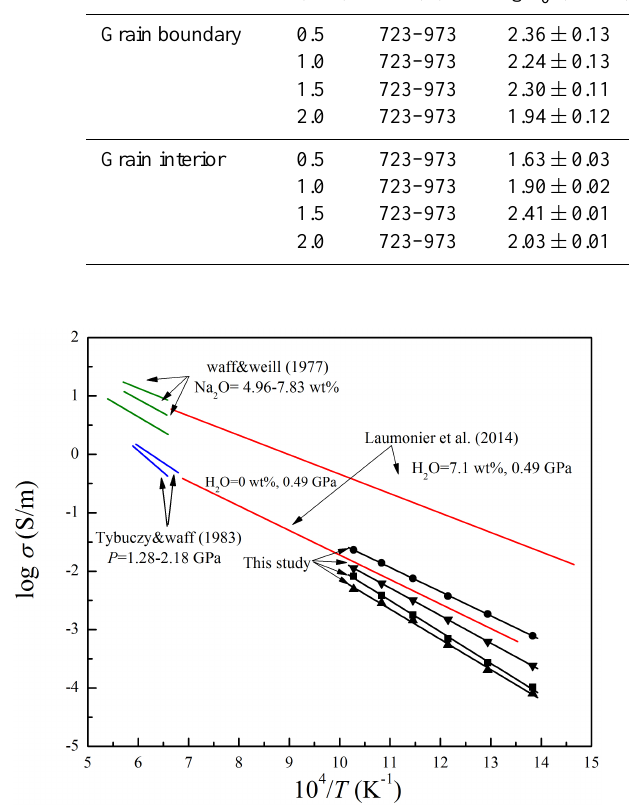
Figure 8. A comparison of grain interior conductivity of quartz an- desite with previous